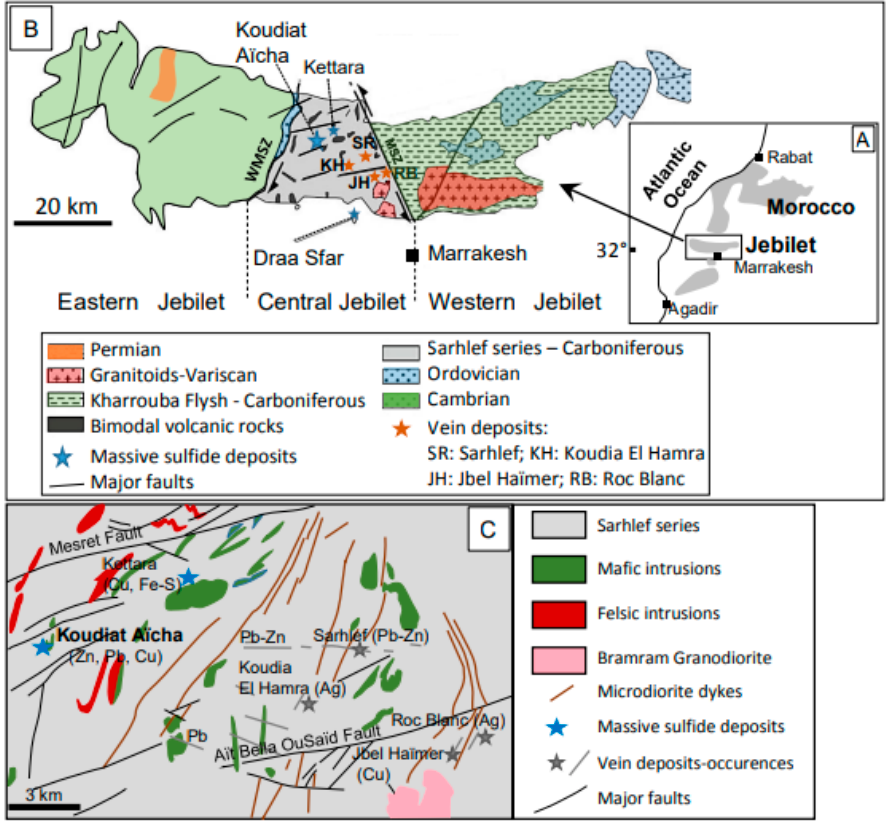
Figure 1. ( A ): Location of the Variscan massifs in Morocco (in grey: centro-meridional domain). ( B ): Geology of the Jebilet massif ([1], in [2]) and locations of the main VMS deposits, Koudiat Aïcha, Kettara and Draa Sfar, and the main vein deposits, JH: Jbel Haïmer (Cu), RB: Roc Blanc (Ag), KH: Koudia El Hamra (Ag) and SR: Sarhlef (Pb-Zn), from [1], modified. (MSZ: Marrakesh Shear Zone; WMSZ: West Moroccan Shear Zone; see text for references). ( C ): Location of Koudiat Aïcha and Kettara massive sulfide deposits and major vein deposits in Central Jebilet (simplified map from [1]).